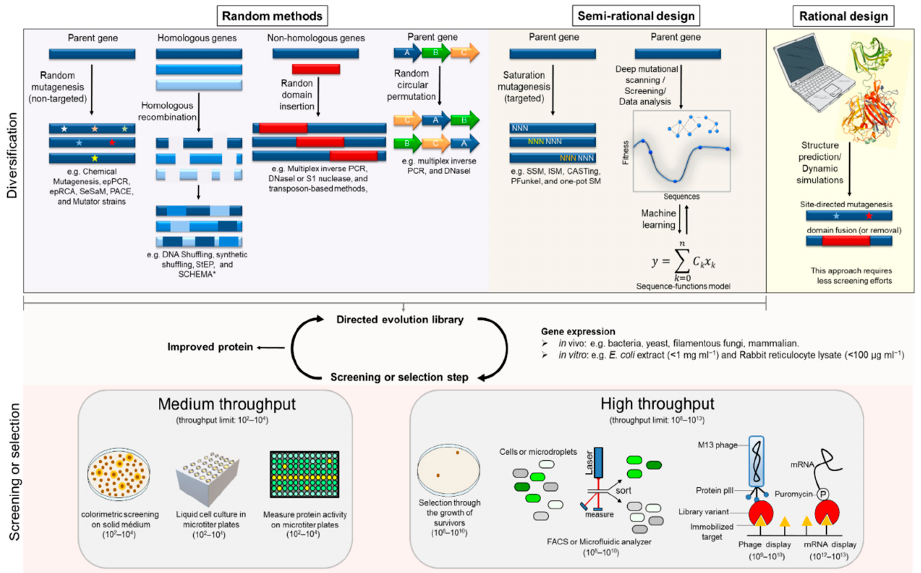
Figure 2. Overview of protein engineering strategies. Protein properties can be improved by using directed evolution (random modes or semi-rational design) or rational design approaches through a process of genetic diversification, gene expression, and screening or selection. For directed evolution, protein variants can be optimized using iterative cycles of this process. * SCHEMA uses structural information to perform recombination; thus, this method can be classified as a semi-rational